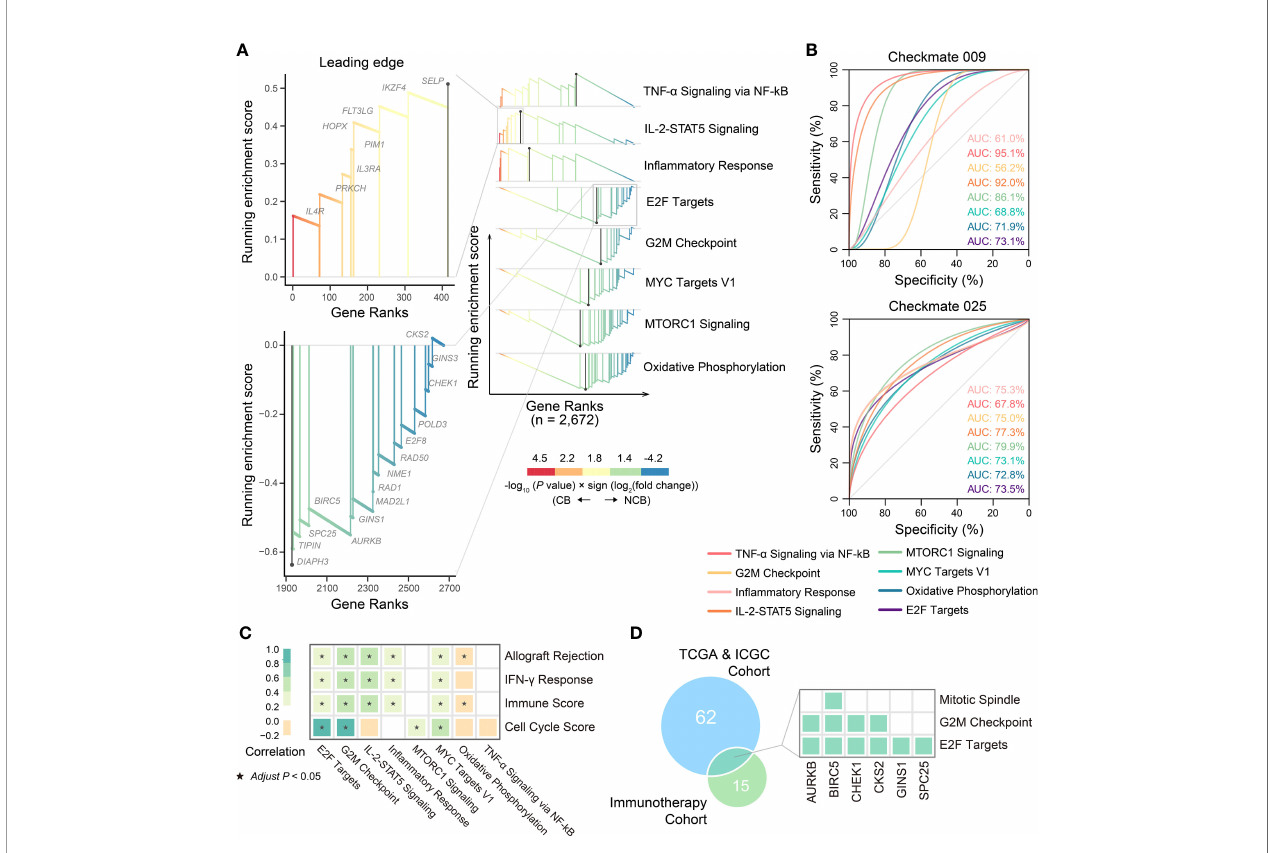
FIGURE 8 | The biological pathways related to immunotherapeutic response. (A) The differential biological processes between CB group and NCB group of ccRCC in immunotherapy cohort and Zoom-in plot showing leading edge genes of IL-2-STAT5 signaling and E2F targets pathways. (B) ROC curves and corresponding AUC of differential biological processes between CB group and NCB group of ccRCC in Checkmate009 (top) and Checkmate025 (bottom) cohorts. (C) Pearson correlation of ssGSEA scores of biological pathways related to ccRCC progression with those related to immunotherapeutic response. (D) Overlap of the leading genes of E2F targets related to ccRCC progression and those related to immunotherapeutic response, and the hallmark pathways covered by